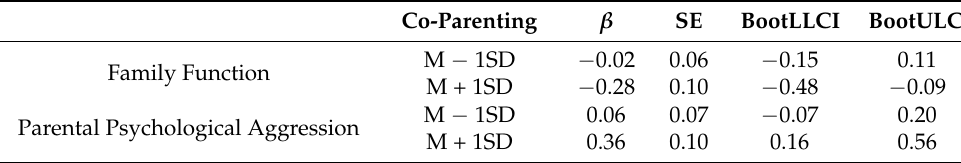
Table 3. The Moderating Effect of